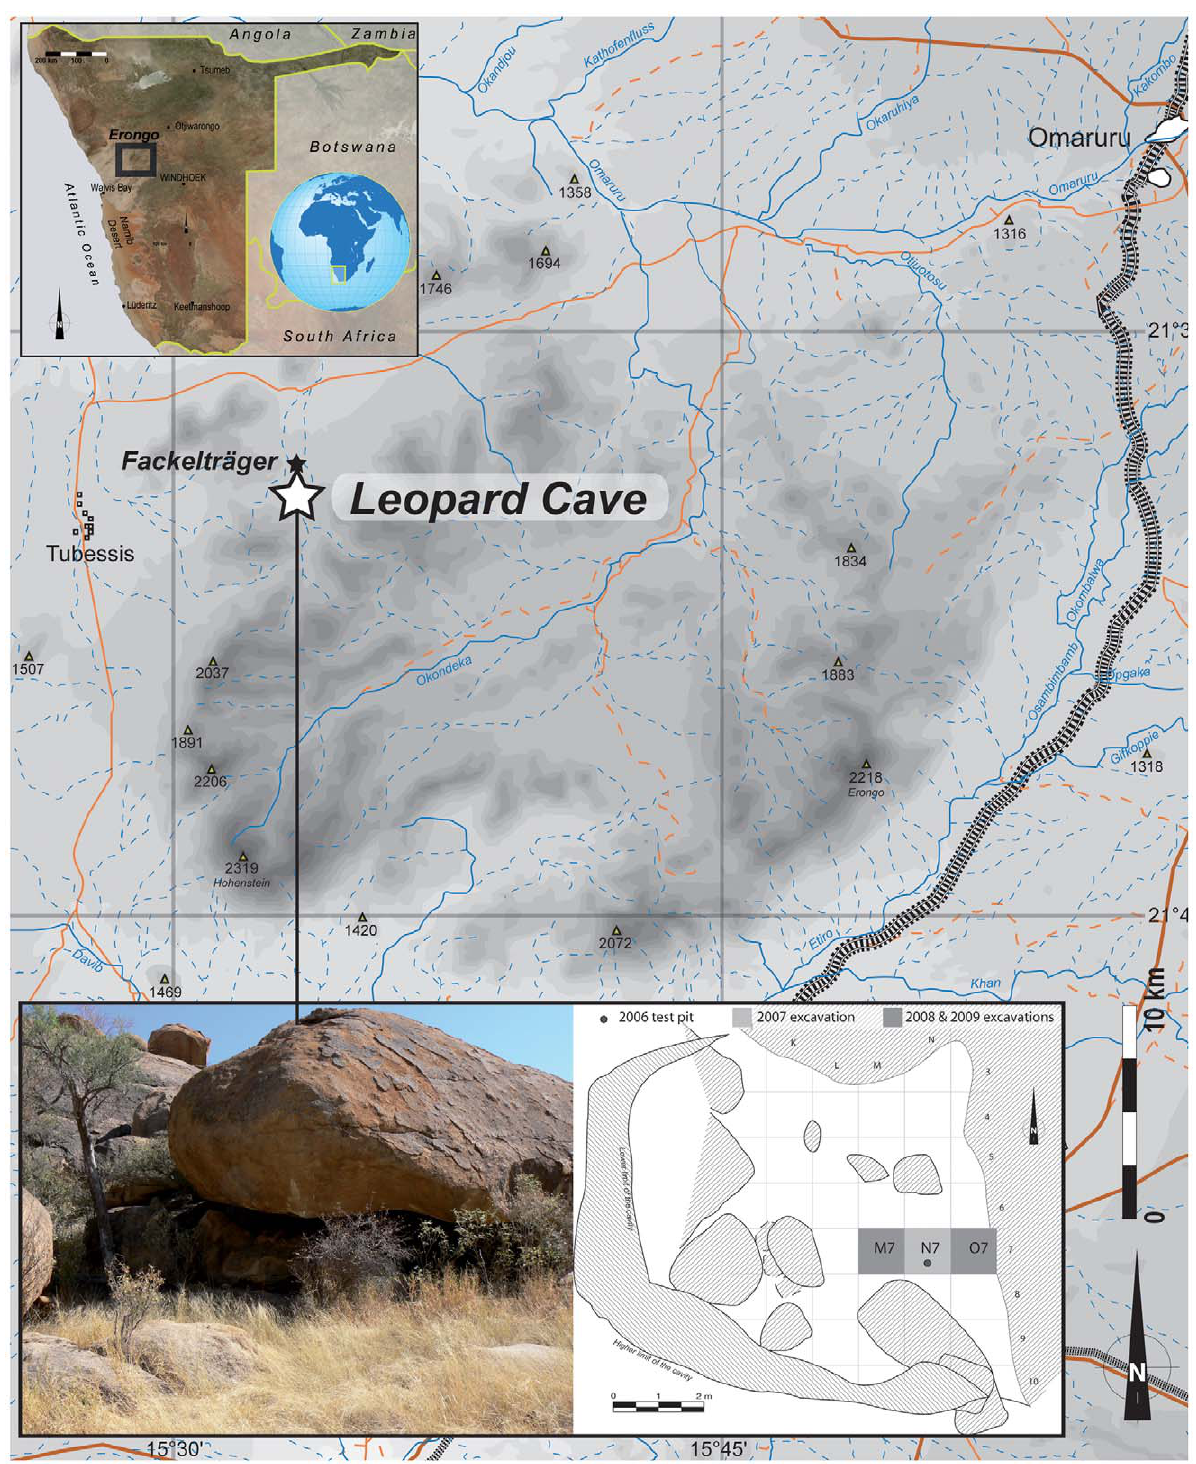
Figure 1. Location of Leopard Cave (Omandumba West, Erongo, Namibia). Plan of the cave and location of the excavated area. doi:10.1371/journal.pone.0040340.g001 Their reduction involved two convex debitage surfaces, alterna- tively and recurrently flaked (radial flaking). Two flaking techniques have been used. The use of a direct percussion with a hard hammer is indicated by the presence of